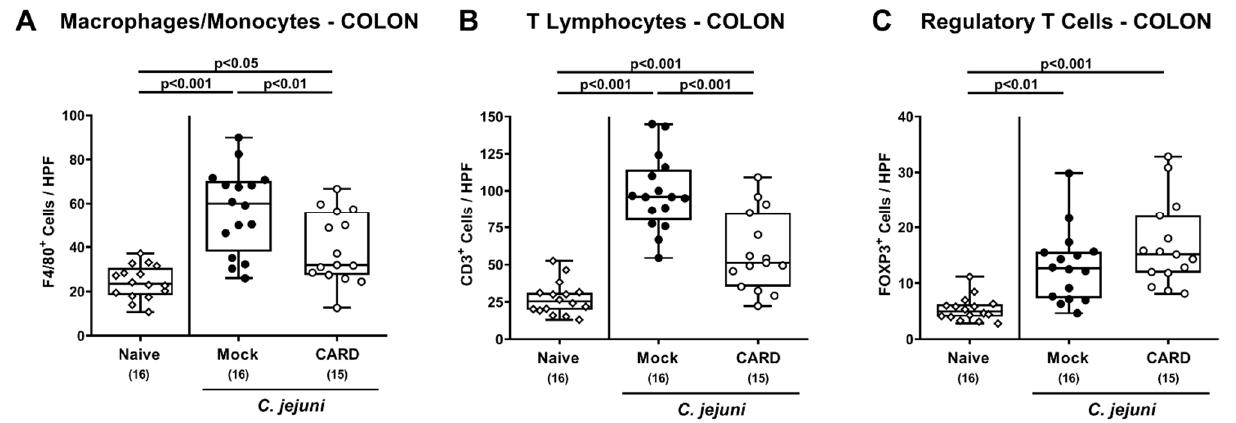
Figure 5. Immune cell responses in the large intestines following oral cardamom essential oil application to C. jejuni -infected microbiota-depleted IL-10 − / − mice. Microbiota-depleted IL-10 − / − mice were infected with C. jejuni strain 81–176 on days 0 and 1 by gavage and perorally challenged with cardamom essential oil (CARD; white circles) via the drinking water starting on day 2 post-infection, whereas mock control mice received vehicle (black circles). On day 6 post-infection, ( A ) macrophages and monocytes positive for cleaved F4/80, ( B ) T lymphocytes positive for CD3, and ( C ) regulatory T cells positive for FOXP3 were enumerated in the colonic mucosa and lamina propria within immunohistochemically stained large intestinal paraffin sections (indicated are the median numbers of positively stained cells from six high power fields (HPF, 400 × magnification) per animal). Naive mice (open diamonds) served as untreated and uninfected controls. The box plots indicating the 75th and the 25th percentiles of the median (black bar within box), the total range, the levels of significance ( p values) as calculated with the ANOVA test, and Tukey post-correction and the number of analyzed mice (in parentheses) are shown. Data were pooled from four independent experiments.